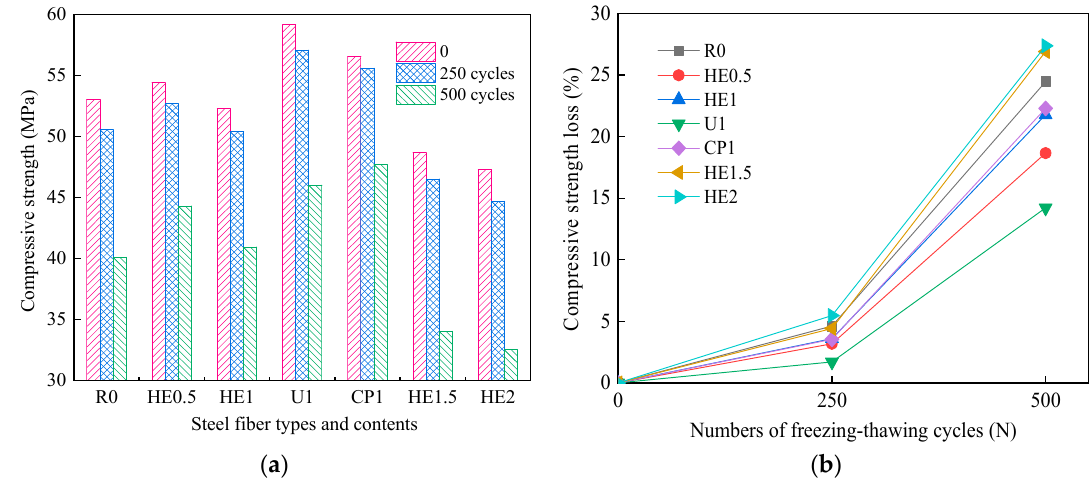
Figure 5. ( a ) Compressive strength and ( b ) compressive strength loss of CGAC reinforced by different types and content of steel fiber after freezing/thawing (F-T) cycles.